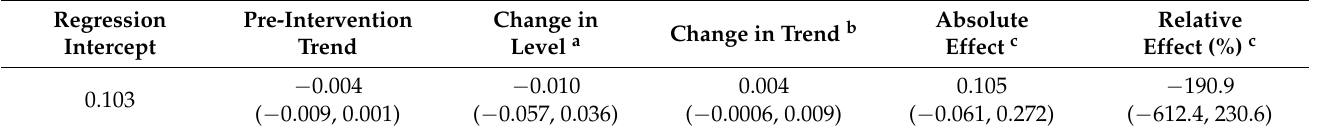
Table 4. Interrupted time-series analysis of changes in sentinel event survival